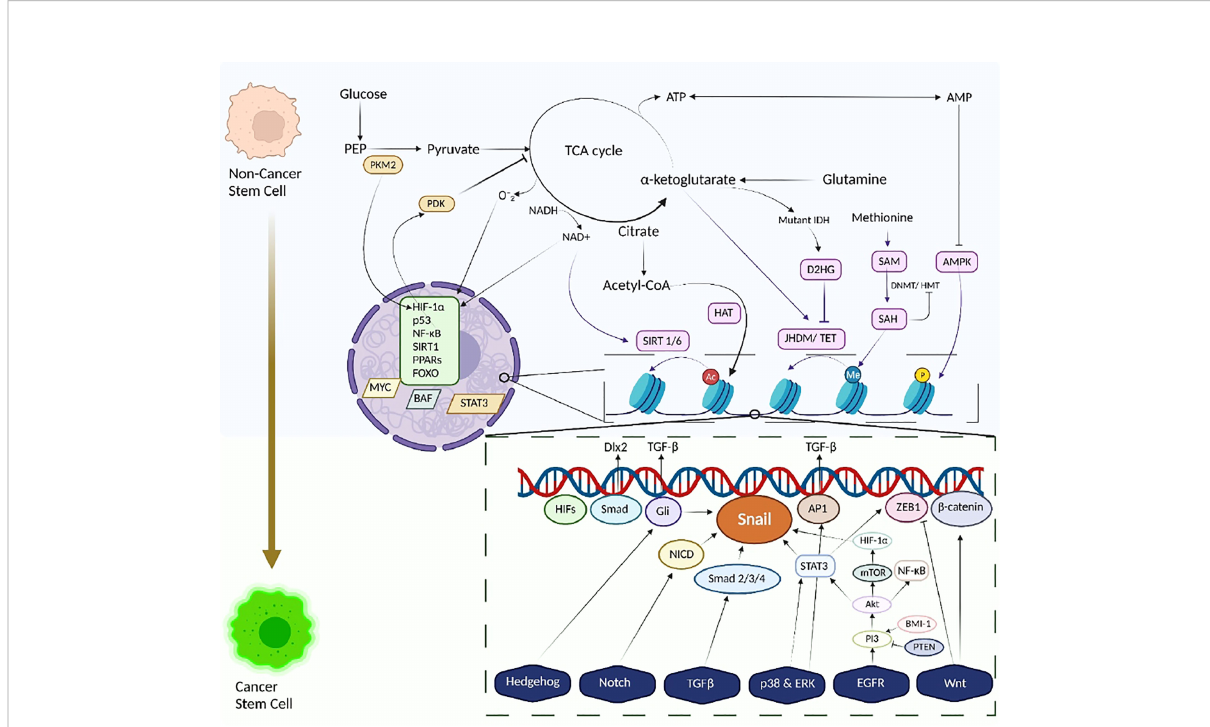
FIGURE 2 The metabolism-epigenetics axis of Cancer Stem Cells. Transformation of Stem cell to Cancer Stem cells along with metabolic reprogramming and Tumour metabolome modulates and links energy-generating biochemical reactions with several epigenetic pathways, thus integrating metabolism and a variety of signaling pathways with epigenetic modi fi cations, histone changes. Signaling pathways involving HIF-1 a and p53 dysregulate glucose and glutamine metabolism, contributing to enhanced production of acetyl Co-A and a -ketoglutarate. This enhanced production in fl uences HAT activity, hence increasing the acetylation pro fi le of cancer cells. A similar response is also observed in NADH/ NAD+ activity wherein the activity of Sirtuins changes. Other metabolites like D2HG and SAM, also play a vital role in epigenetic modi fi cations, eliciting and inhibiting HMT/ DNMT activities. Energetic stress is also observed due to activation of AMPK leading to histone phosphorylation. The dysregulation of the metabolic homeostasis, in accordance with aberrant signaling pathways or mutations and epigenetic modi fi cations, reprograms the stemness and pluripotency of the normal/ cancer cells towards cancer stem cells. Cancer stem cells exploit these altered metabolic pathways for their bene fi t and